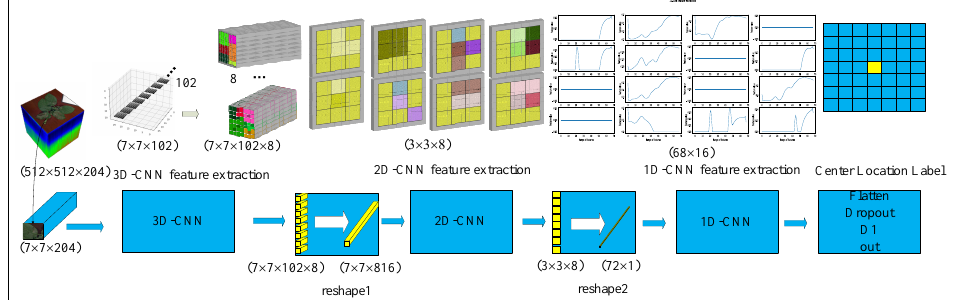
Figure 4. Leafpixel classification based on multidimensional fusion of